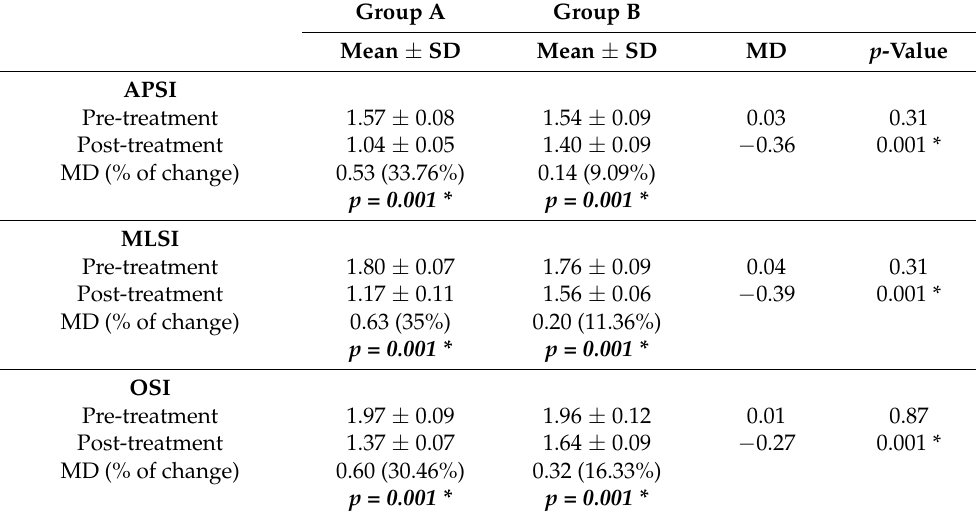
Table 4. Mean stability indices of both